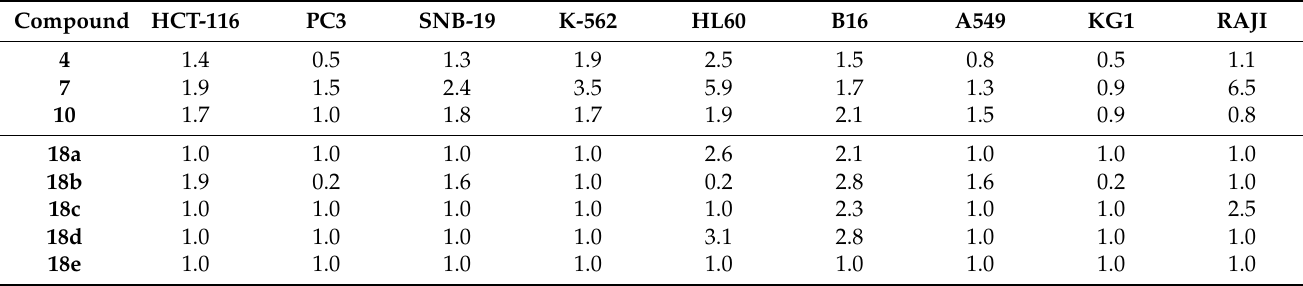
Table 2. Selectivity index calculated using the ratio of cytotoxicity between L929 cell line and each cancer cell lines. * Data previously described